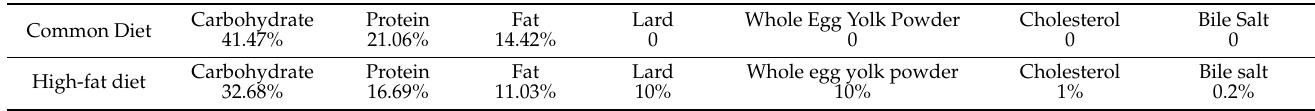
Table 1. The nutritional information for the